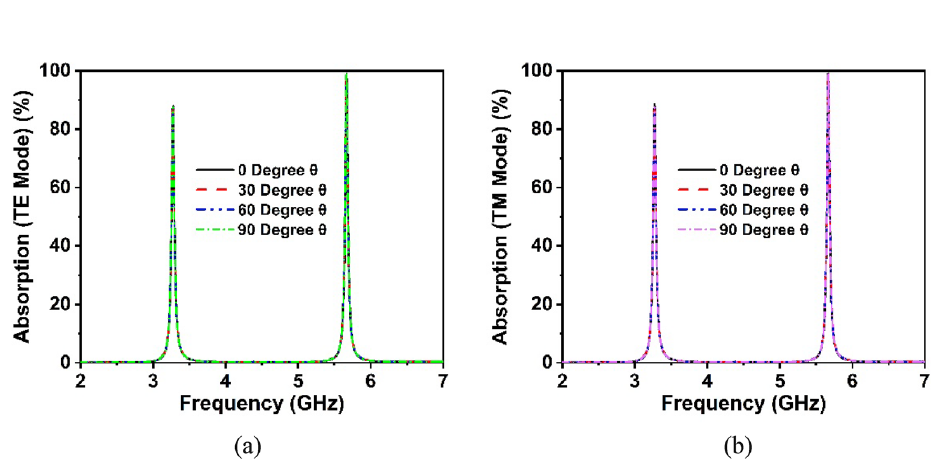
Figure 19. Absorption characteristics for various angles of oblique incidence in ( a ) TE and ( b ) TM modes of